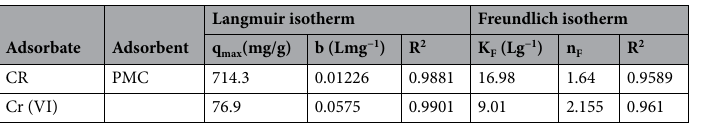
Table 2. Langmuir and Freundlich isotherm model parameters for Congo red dye and Cr(VI) at 30 °C.